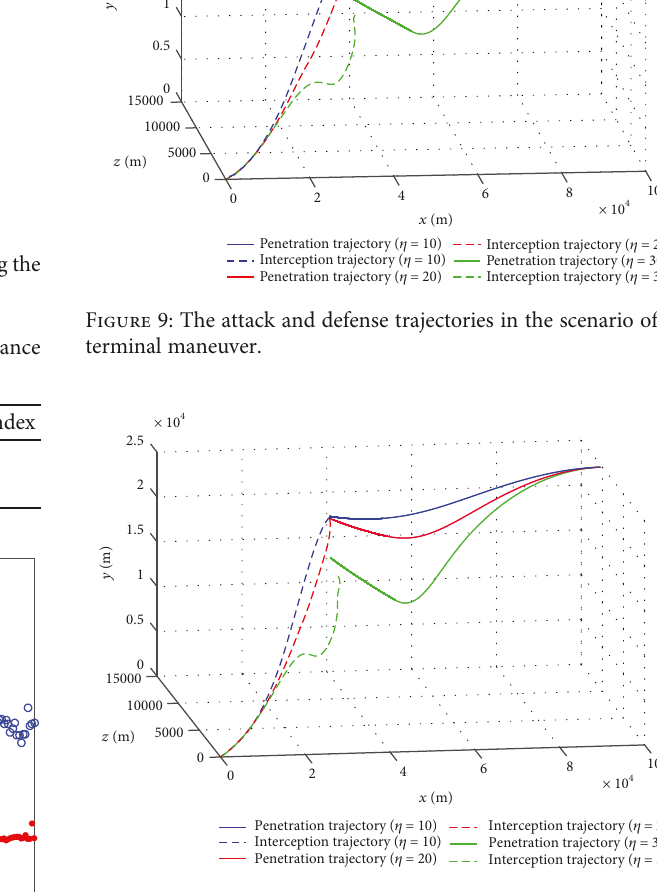
Figure 10: The attack and defense trajectories in the scenario of the maximum overload terminal maneuver.